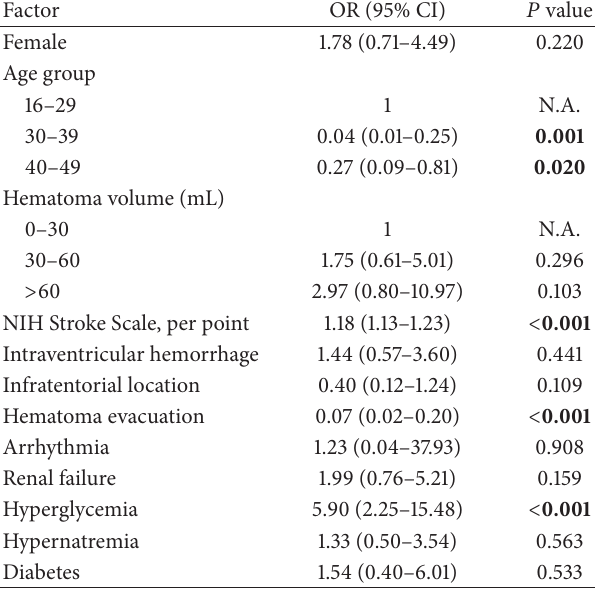
Table 4: Logistic regression analysis of hyperglycemia and 3-month mortality in young patients with intracerebral